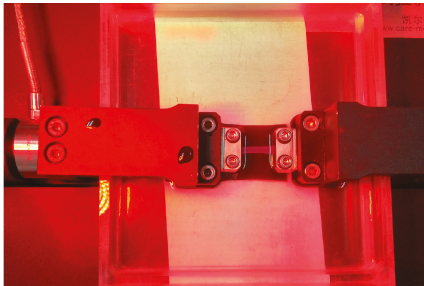
Figure 3: Clamping and water bath system of corneal strip.